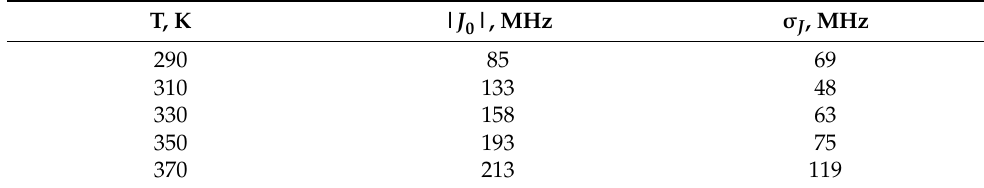
Table 1. Parameters corresponding to the best fit of the EPR spectra of biradical 3 in a toluene solution at different temperatures. T, K | J 0 |, MHz σ J , MHz 290 85 69 310 133 48 330 158 63 350 193 75 370 213 119